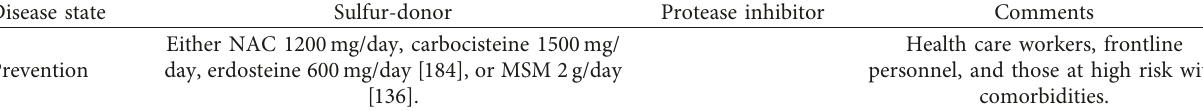
Table 1: Summary of a proposed therapeutic strategy to prevent and combat